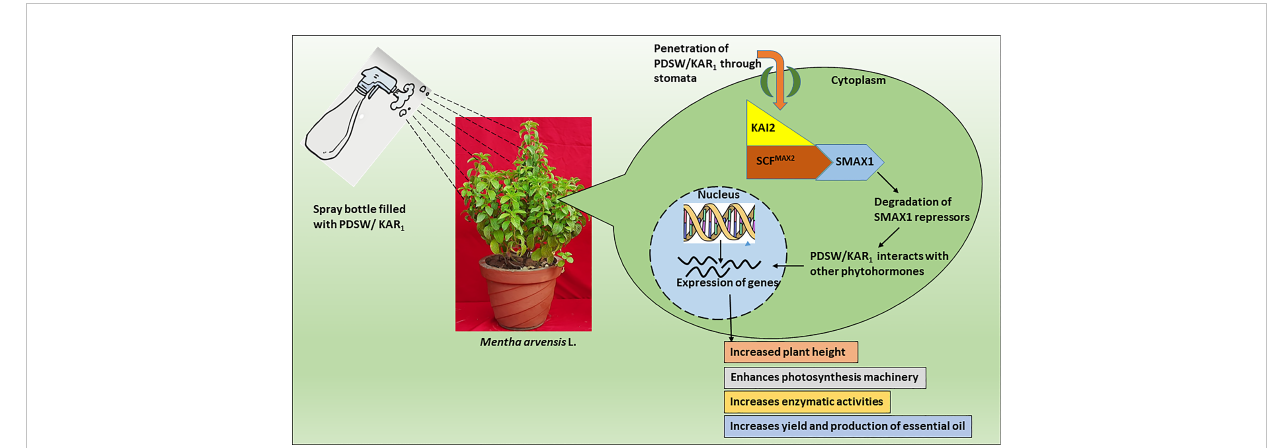
FIGURE 8 Possible schematic representation of perception by mint plant and mechanism of action of PDSW/KAR 1 . PDSW/KAR 1 is absorbed through stomata of mint-plant leaves. PDSW/KAR 1 is perceived by KAI2 protein that forms a proteosomal complex with MAX2 protein and SMAX1 repressors. After ubiquitin-mediated proteosomal degradation of repressors, PDSW/KAR 1 interacts with indigenous phytohormones that enhance the expression of genes related to growth, development and essential oil productivity of mint